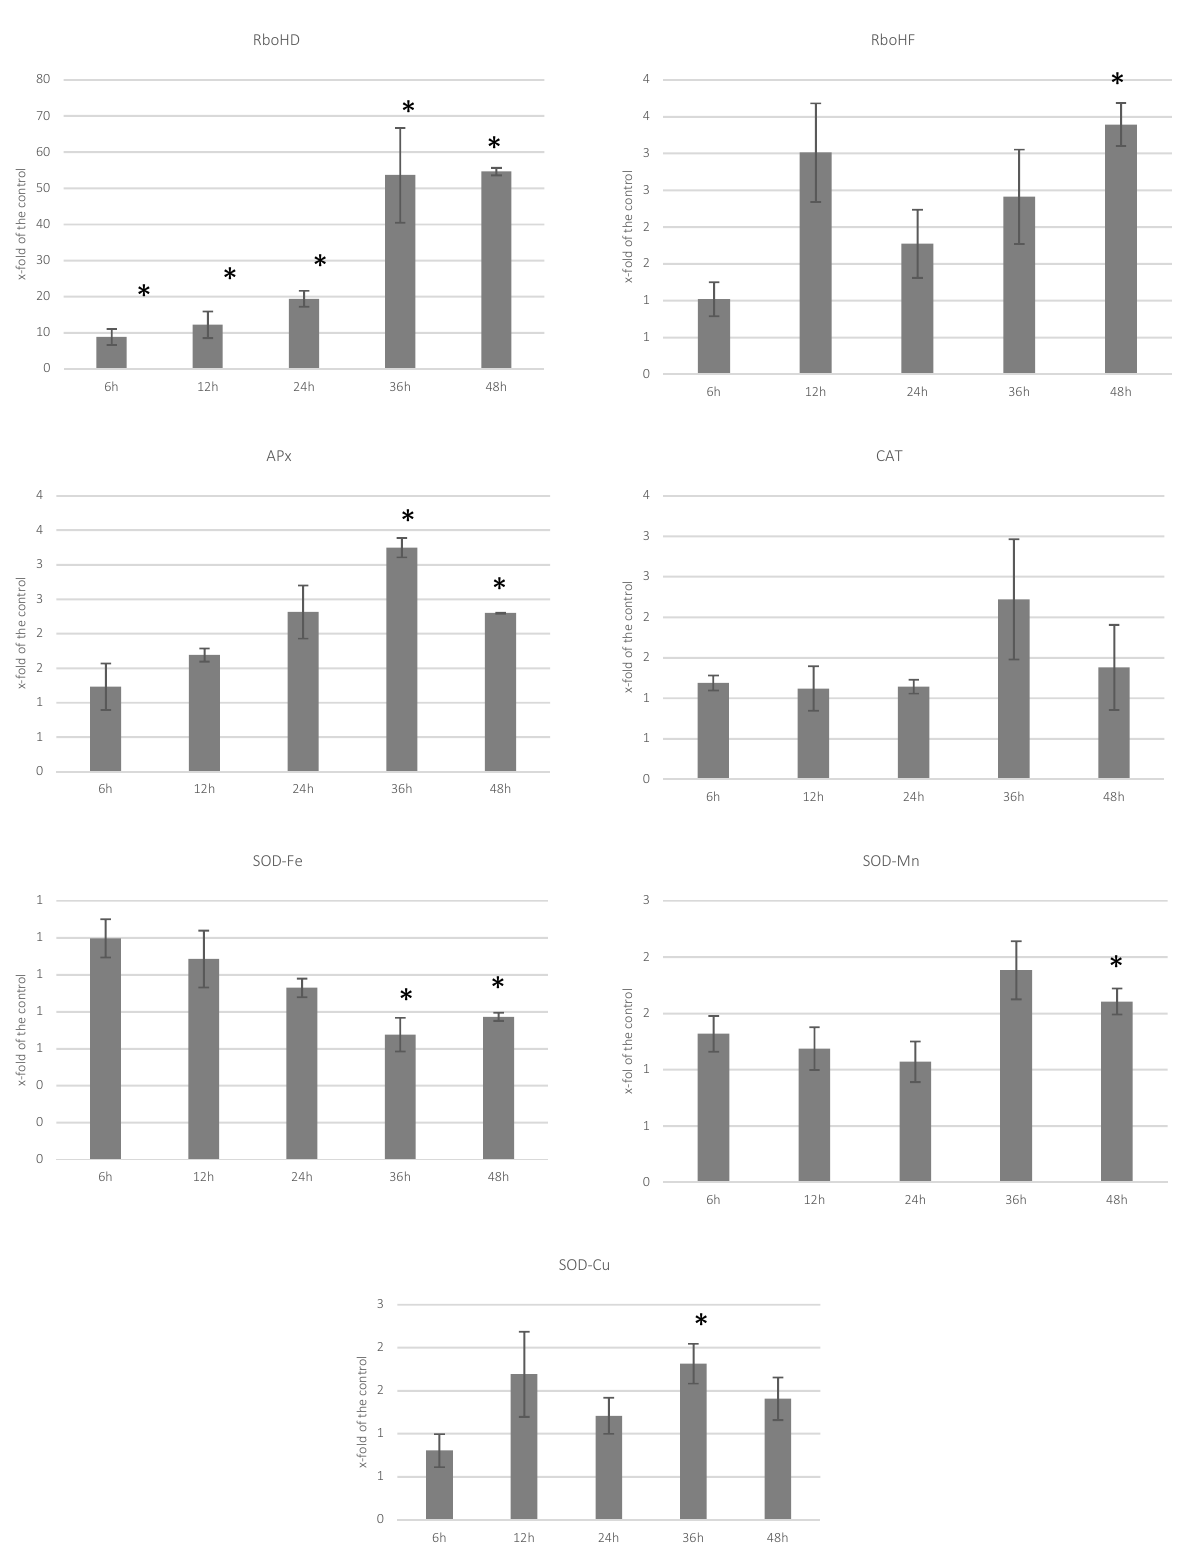
Figure 2. Transcript levels of genes involved in ROS production and processing ( RboHD —NADPH oxidase D, RboHF —NADPH oxidase F, APx —ascorbate peroxidase, CAT —catalase, SOD —superoxide dismutase) in flax seedlings treated with F. culmorum measured at five time-points after the infection. Results (means of three biological repeats ± sd) are presented as fold of the control (equal to 1). Statistically significant changes are marked with